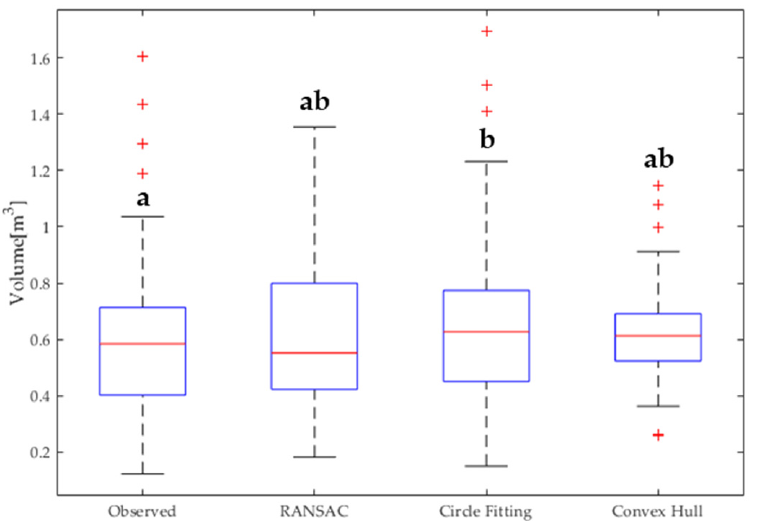
Figure 8. Box and whisker plots of the observed and estimated total stem volume. The letters (a and b) indicate whether or not there were significant differences between the groups at a 0.05 significance level. Table 5. Wilcoxon signed-rank test.